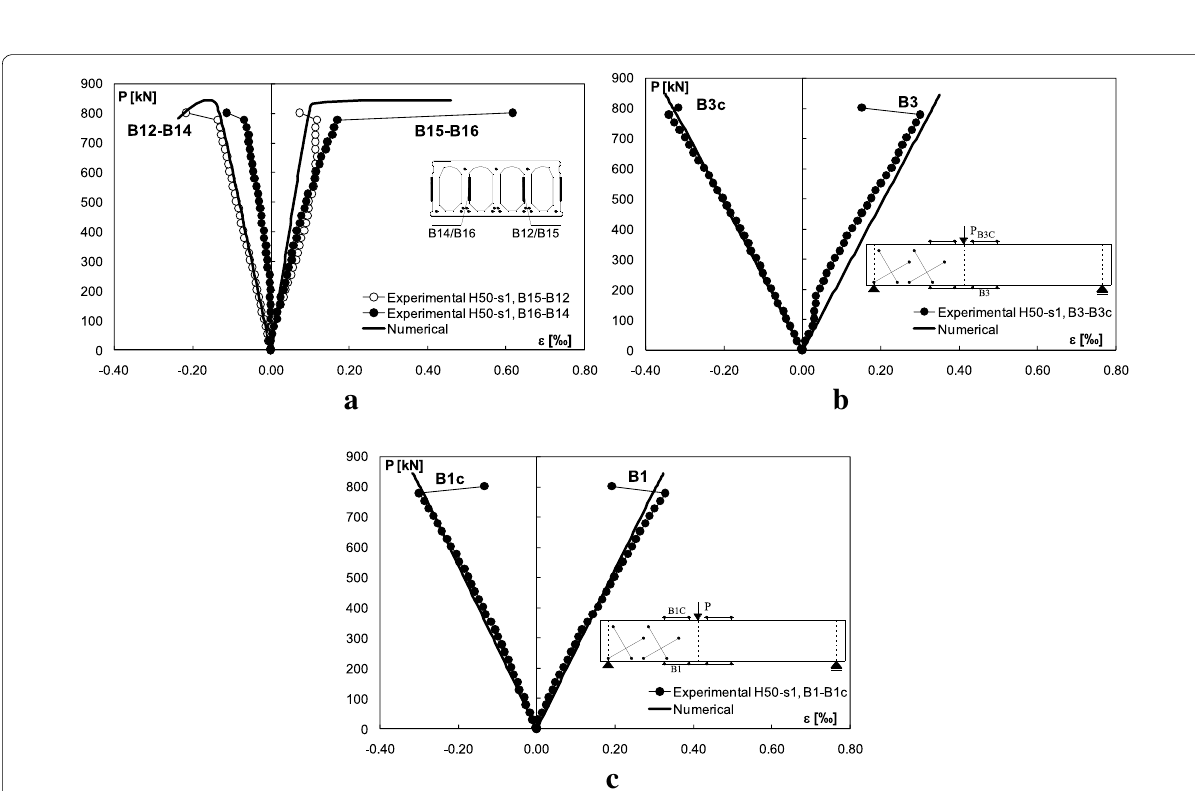
Fig. 17 Shear tests: comparisons between experimental and numerical results in terms of applied load P versus strain ε obtained from devices a B15-B16 (T) and B12-B14 (C); b B3 (T) and B3c (C); c B1 (T) and B1c (C) for specimen